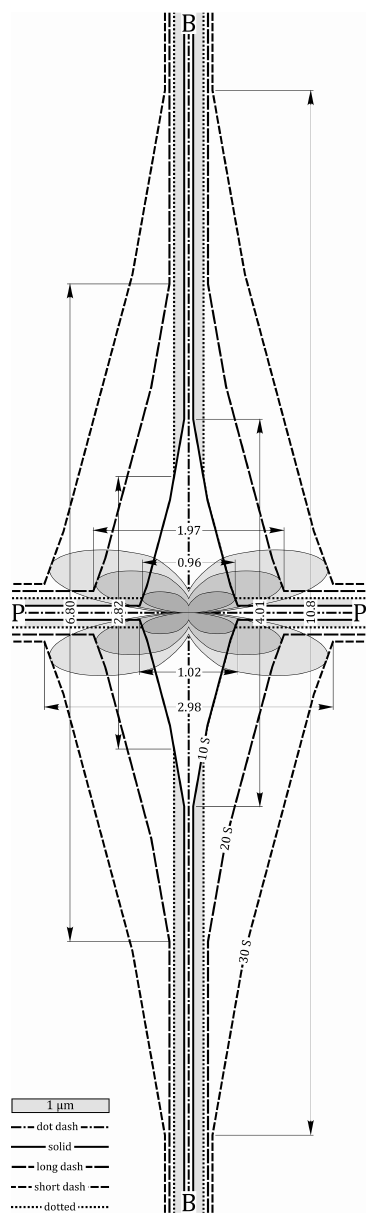
Figure 5. Calculation of the track openings in a basal and a prism face of Durango apatite etched in 5.5M HNO 3 at 21 ◦ C for 10, 20 and 30s. The shaded four-leaf clovers in the center are the envelopes of the etch rate vectors (Aslanian et al., 2021), scaled to represent the displacement of lattice planes after 10 (dark gray), 20 (middle gray) and 30s etching (light gray). The drawing plane is a prism face with the c axis running from left to right through the center. The basal face is perpendicular to the c axis and to the drawing plane, intersecting it along the line B–B (dot dash) running from top to bottom. A prism face perpendicular to the drawing plane intersects it along the line P–P running from left to right (dot dash). The diamond shapes are the etch figures formed by the fastest etching planes after 10 (solid), 20 (long dash) and 30s etching (short dash; Jonckheere et al., 2019, 2022). Their intersections with the etched basal surface (B–B) and prism surface (P–P) determine the sizes of the track openings ( D BAS , D PAR ) in these surfaces. The track openings in the prism face are measured in the horizontal direction. The sizes of the etch pits in the basal face are measured in the vertical direction. The numerical values ( D MOD in µm) are summarized in Table 1. As discussed in the text, their calculation involves a correction for an initial stage of accelerated surface etching due to polishing damage. We assume that in both faces a total thickness of 0.15µm was removed after the first 10s etch step, which is 2–3 times the etch rate of the undamaged surfaces. The additional thickness removed during this step is shown by the elongated shaded areas bordered by the dotted lines. The reason for this correction is discussed in the